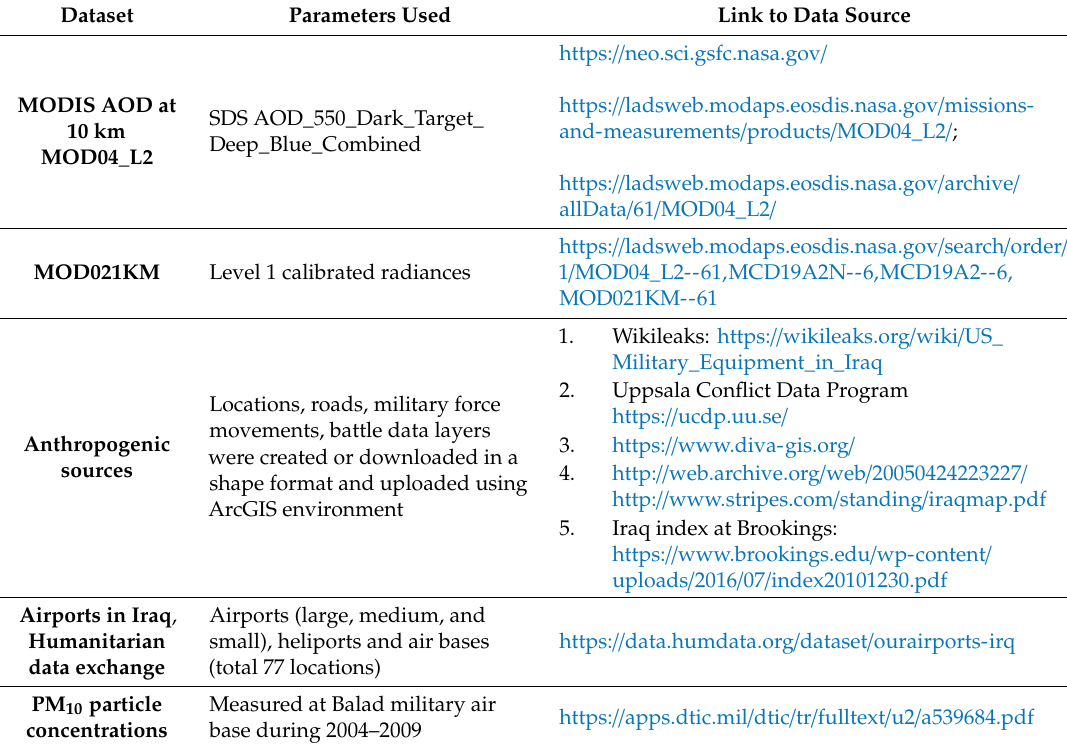
Table 1. List of datasets used in our